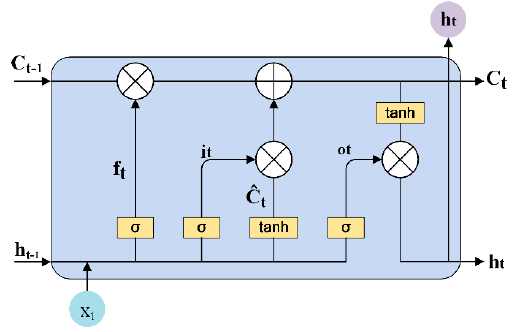
Figure 6. LSTM unit structure.